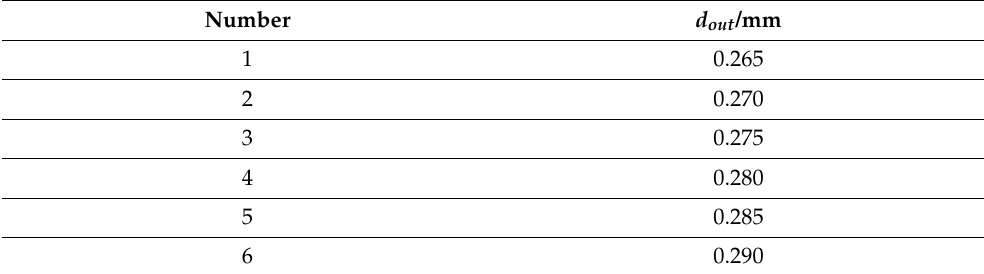
Table 3. Simulative geometric dimensions of outlet throttle